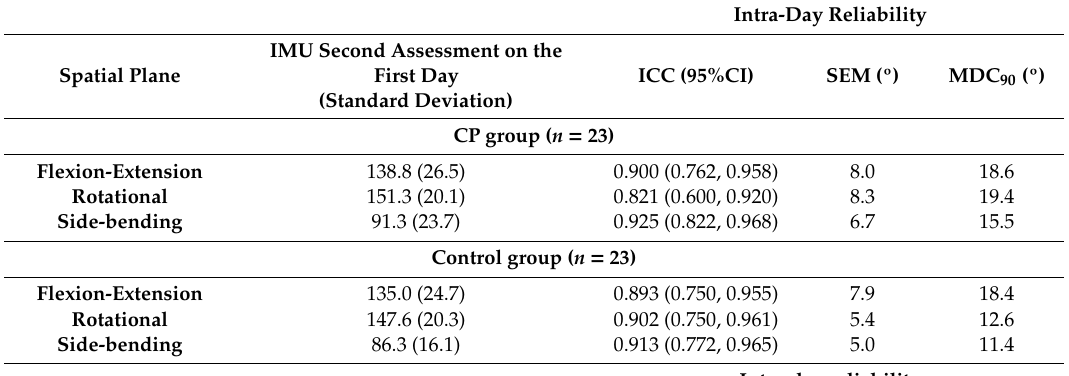
Table 3. Intra-day and inter-day reliability of the IMU by